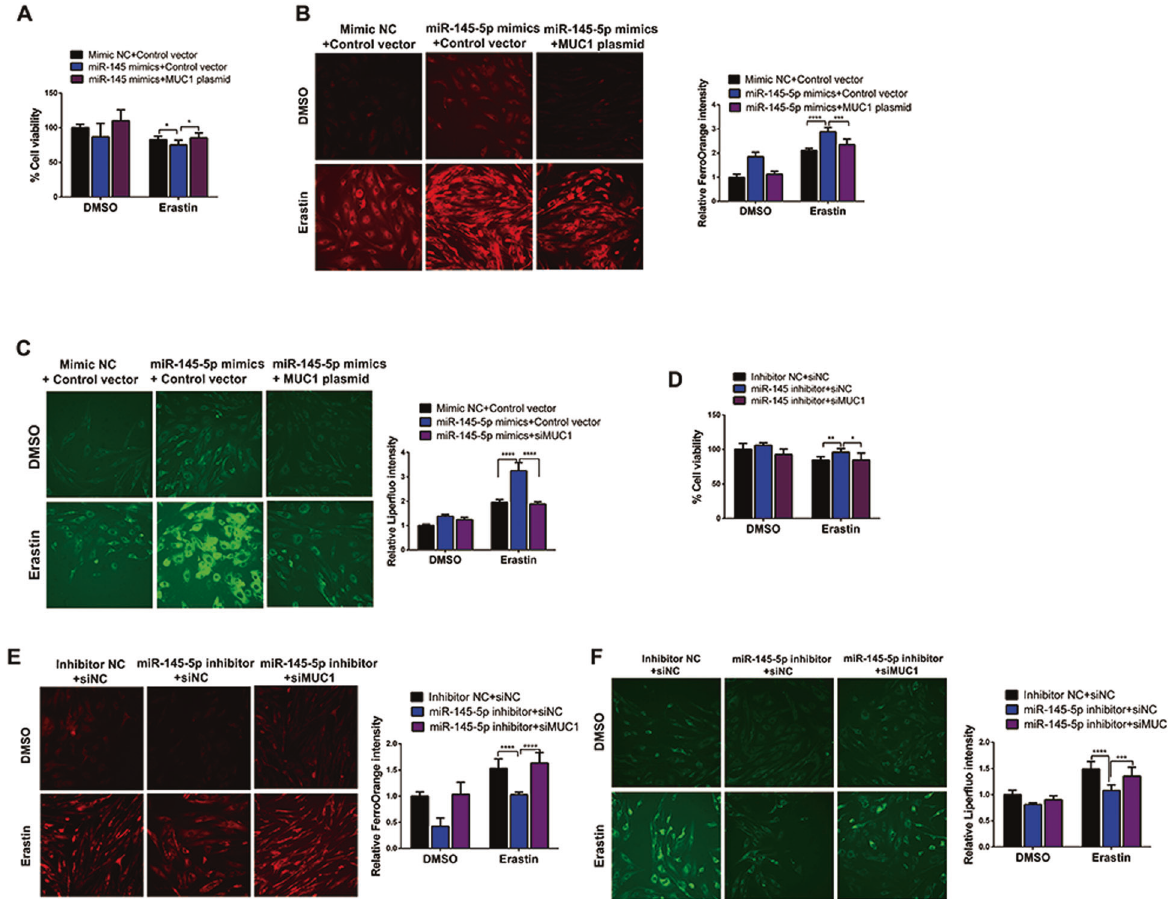
Fig. 5 MiR-145-5p promoted erastin-induced ferroptosis in EESCs by regulating MUC1. A Cell viability was evaluated in miR-145-5p- overexpressing cells after cotransfection with the MUC1 plasmid. B , C Intracellular Fe 2 + and Liper fl uo levels were evaluated in miR-145-5p- overexpressing cells after cotransfection with the MUC1 plasmid (magni fi cation, ×200). D Cell viability was evaluated in cells with miR-145-5p inhibition after cotransfection with siMUC1. E , F Intracellular Fe 2 + and Liper fl uo levels were evaluated in miR-145-5p-inhibited cells after cotransfection with siMUC1 (magni fi cation, ×200). All data are shown as the mean ± SD of three independent experiments (NS is nonsigni fi cant, * P < 0.05, ** P < 0.01, *** P < 0.001, **** P < 0.0001). Statistical signi fi cance was calculated using Student ’ s t test. EESC ectopic endometrial stromal cell, MUC1 mucin 1, siNC negative control siRNA, siMUC1 siRNA targeting MUC1, mimic NC negative control miRNA mimic, inhibitor NC negative control miRNA